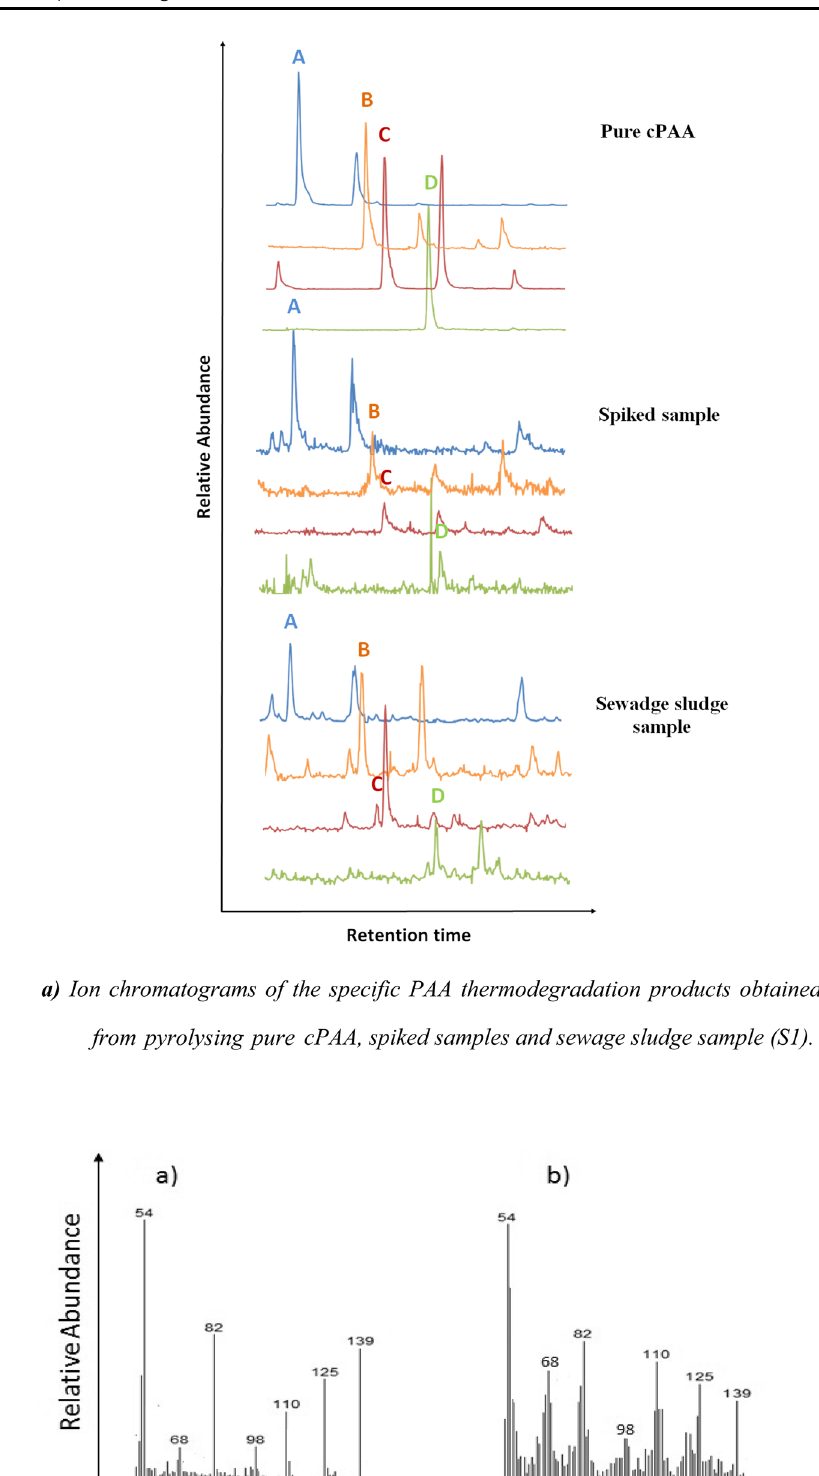
Fig. 4 a Ion chromatograms of the specific PAA ther- modegradation products obtained from pyrolysing pure cPAA, spiked samples and sewage sludge sample (S1). b Mass spectrum of the peak C obtained by TMAH- thermochemolysis-GC–MS of: a pure cPAA (first panel) and b sewage sludge